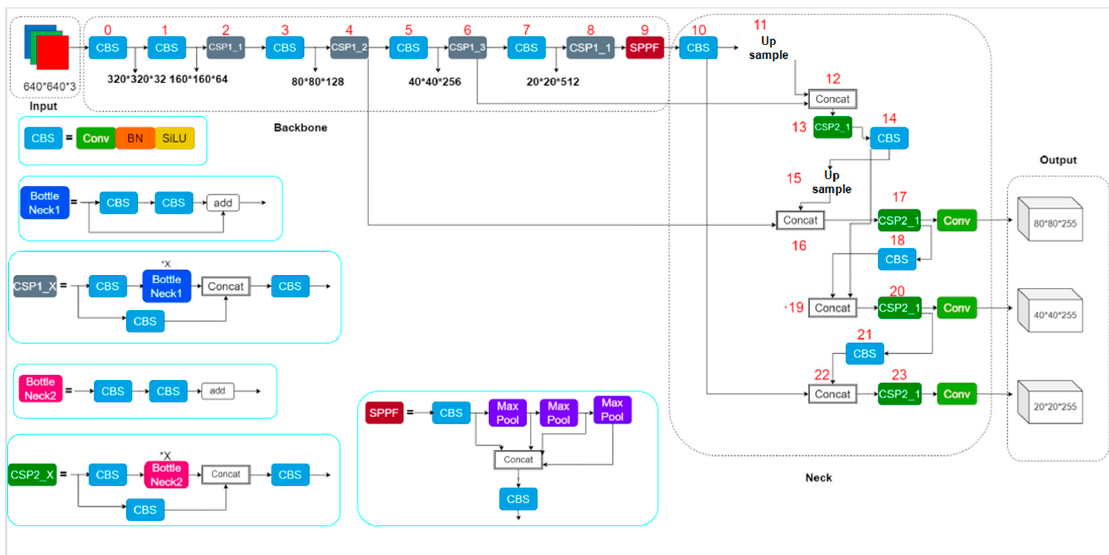
Figure 3. Model structure of YOLOv5s version 6.1.